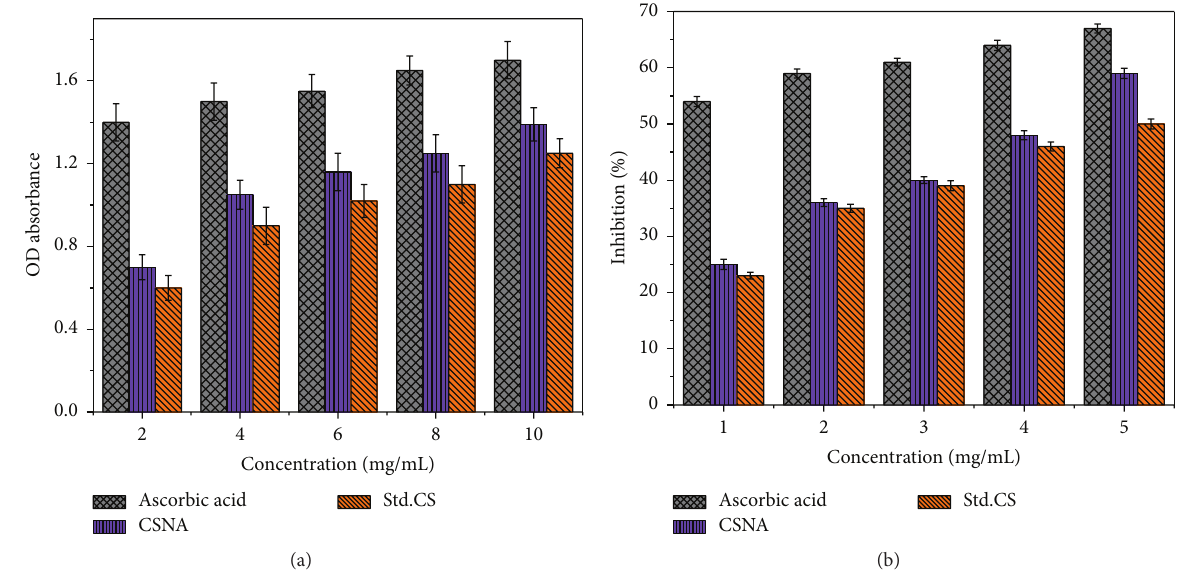
Figure 4: (a) Antioxidant reducing power and (b) superoxide radical scavenging ability of CSNA and